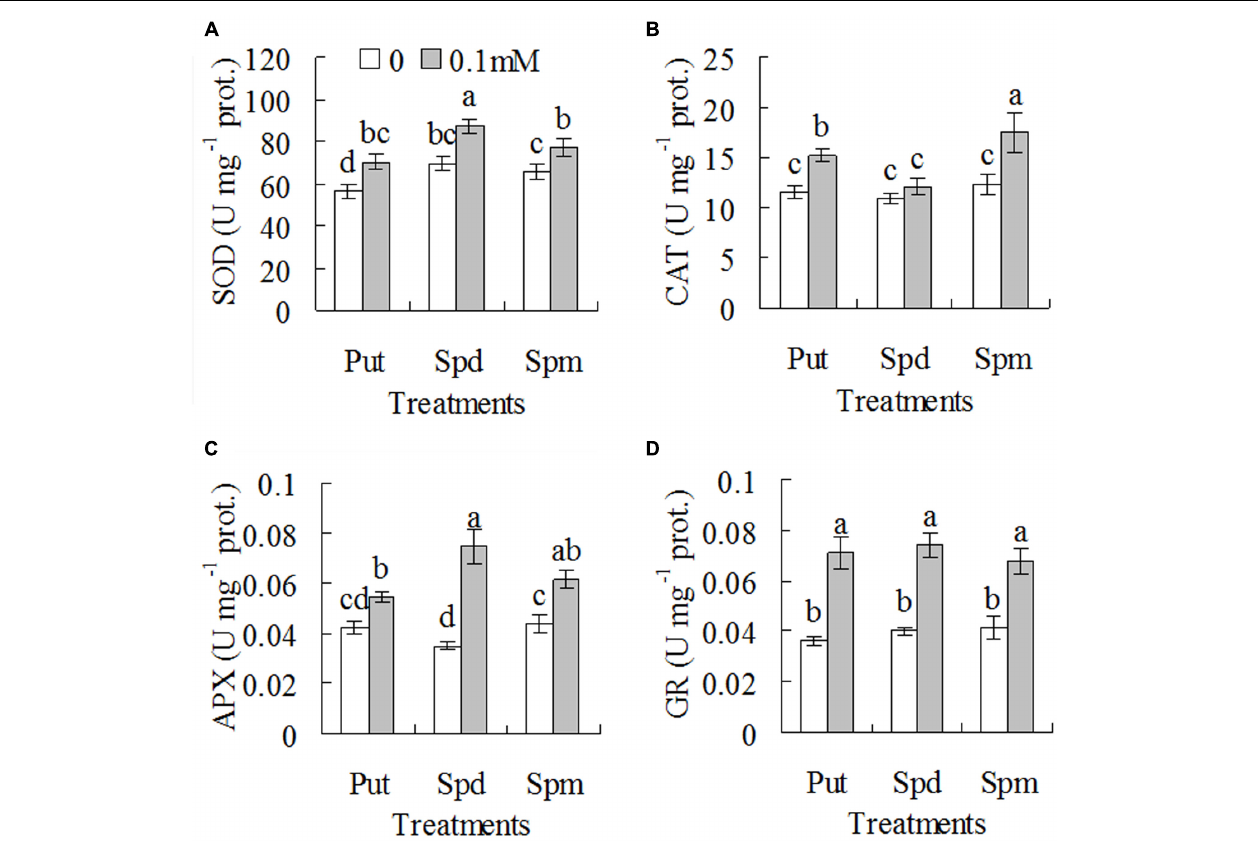
FIGURE 6 | Activities of superoxide dismutase (A) , catalase (B) , ascorbate-peroxidase (APX, C ), and GSH reductase (D) in the wild type plants (ZC1) as affected by exogenous putrescine (Put), spermidine (Spd), and spermine (Spm). Means of three independent plant samples and the standard errors are presented; the same letter indicates no significant difference at P < 0.05 within the same polyamine